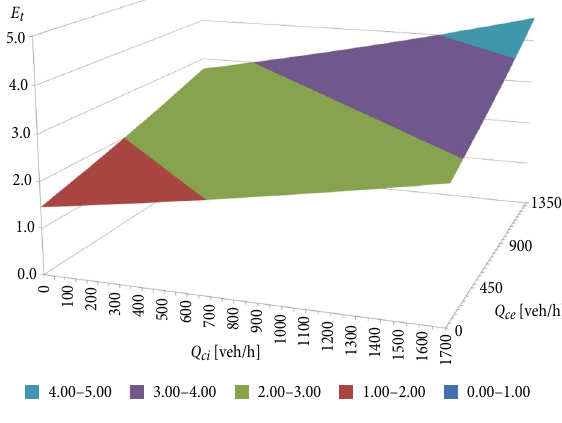
Fig. 7. E t for the left lane on minor entry (case – 20 % of heavy